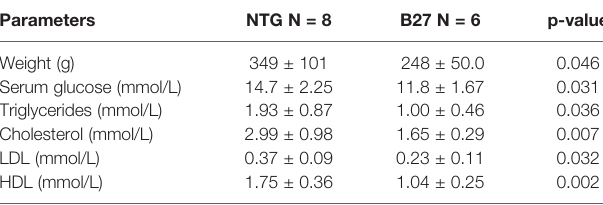
TABLE 1 | Body weight and serum fat parameters in no-transgenic and HLA-B27 transgenic